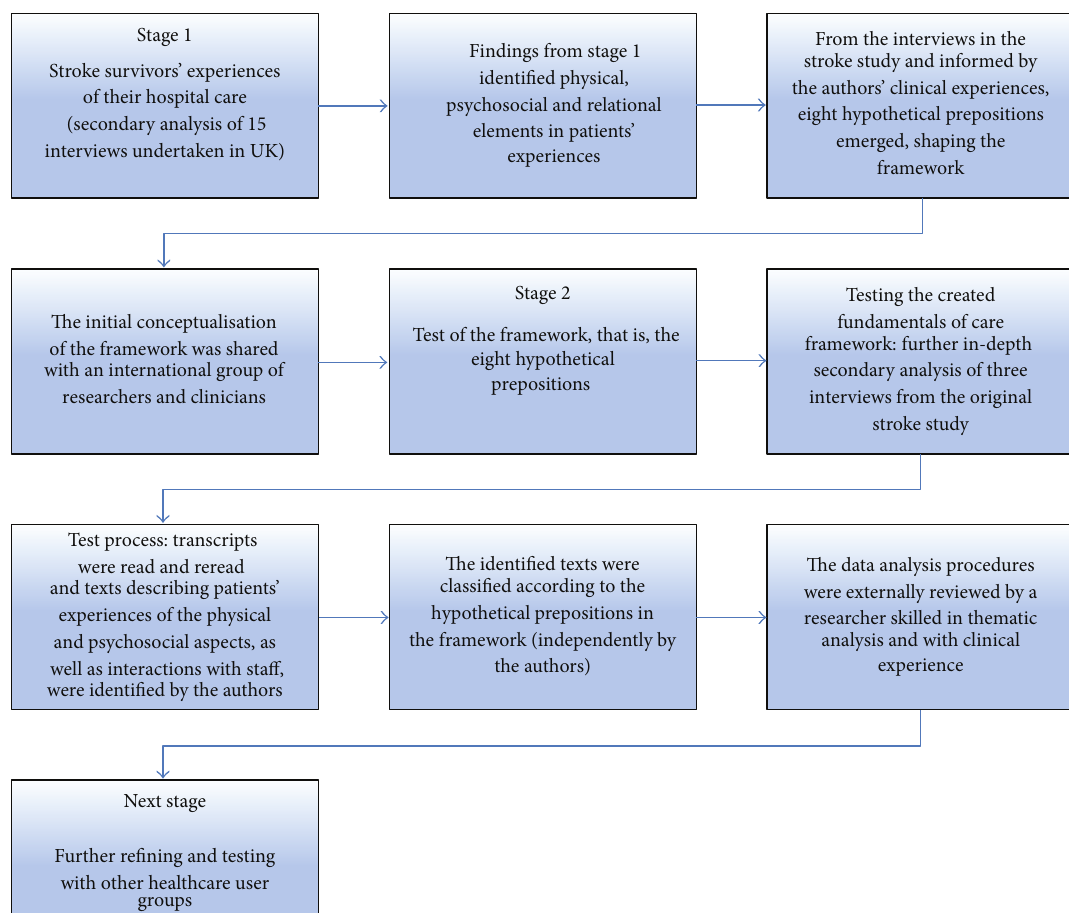
Figure 1: Processes and procedures in the development and testing of the conceptual